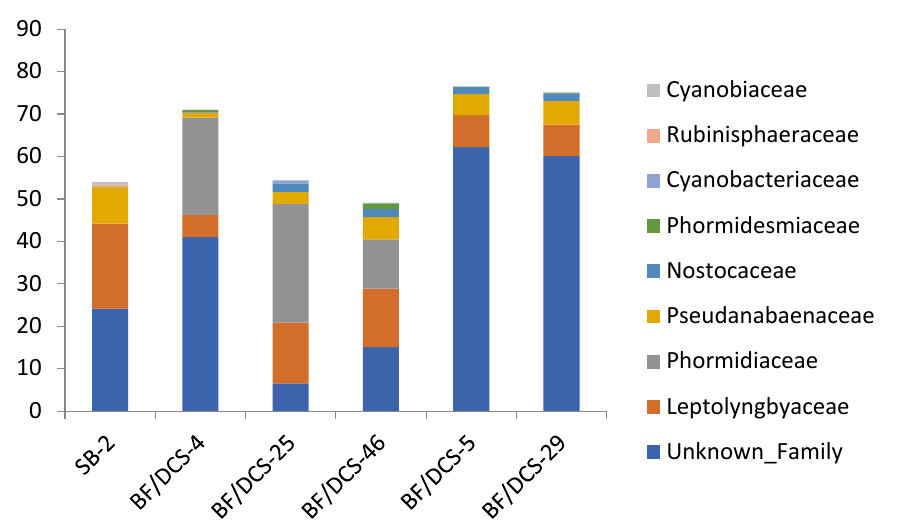
Figure 5. Representation of bacterial families (more than 1% in the microbiome) in the studied habitats (%, samples designations correspond to Table 1).